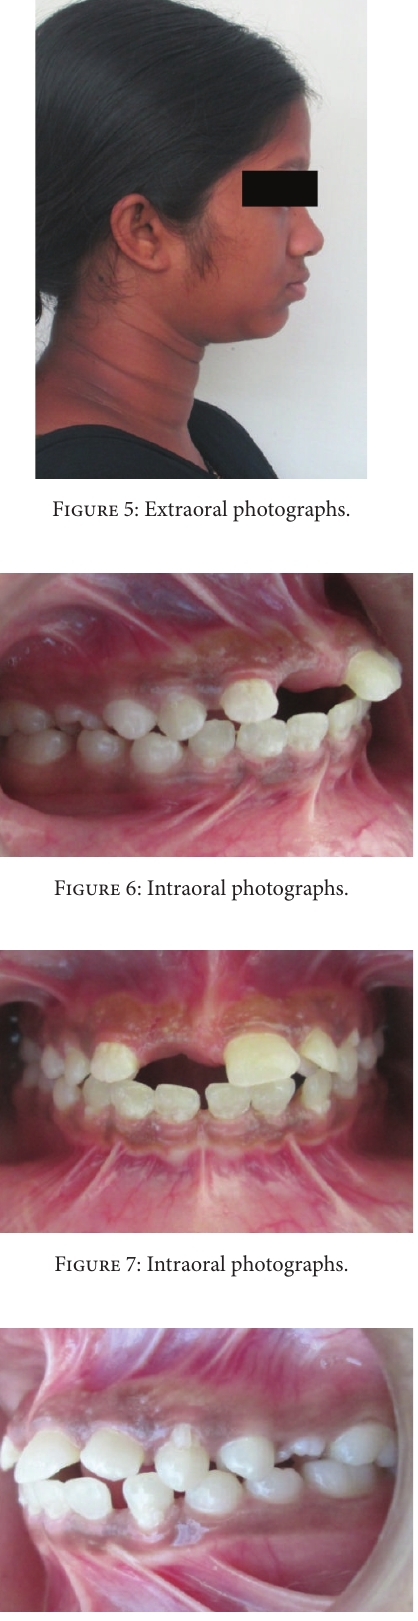
Figure 8: Intraoral photographs.